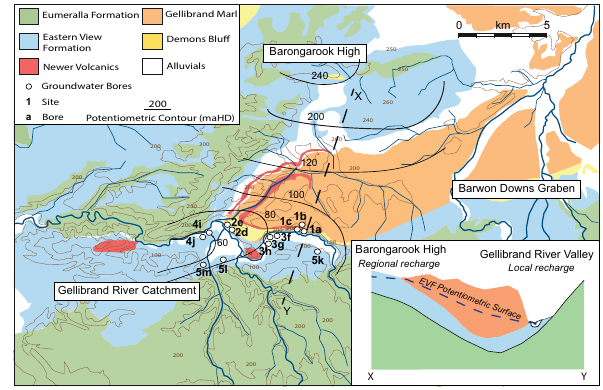
Figure 1. Geology, groundwater flow and cross-sectional view of the upper part of the Gellibrand River Catchment (the Gellibrand Valley). Potentiometric contours for the Eastern View Formation are created from groundwater data (Water Resources Data Warehouse, 2013) and are expressed in metres above Australian Height Datum (mAHD). Sampled groundwater bores are also shown. Letters refer to bores in Table 1.